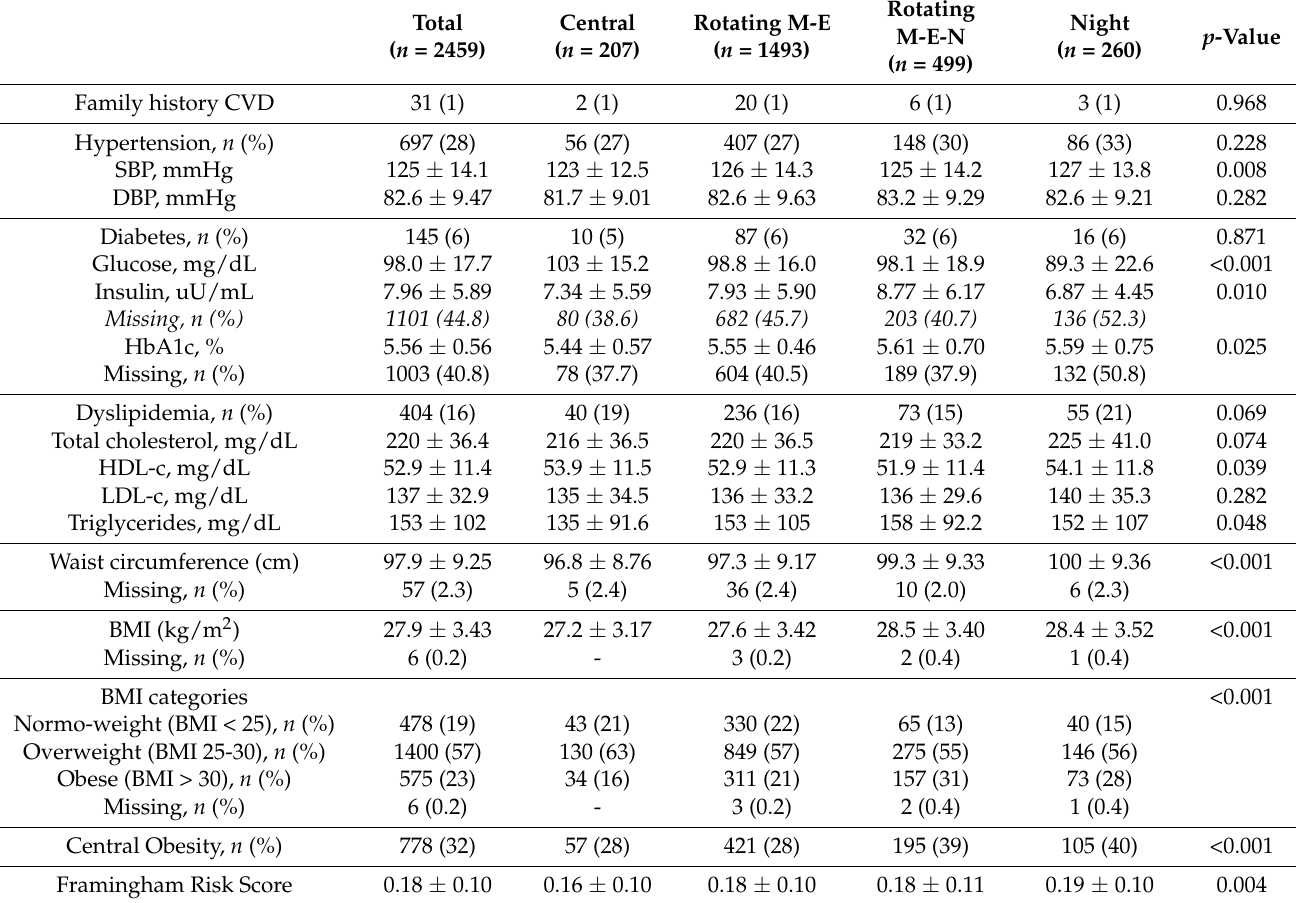
Table 2. Cardiovascular risk factor of AWHS population by working shift. Total Central Rotating M-E ( n = 2459) ( n = 207) ( n = 1493)